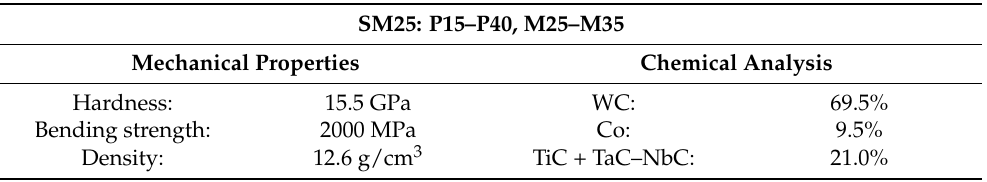
Table 1. Mechanical properties and chemical analysis of the SM25 (P15–P40, M25–M35) cemented carbides (according to PN-81/H-89500).